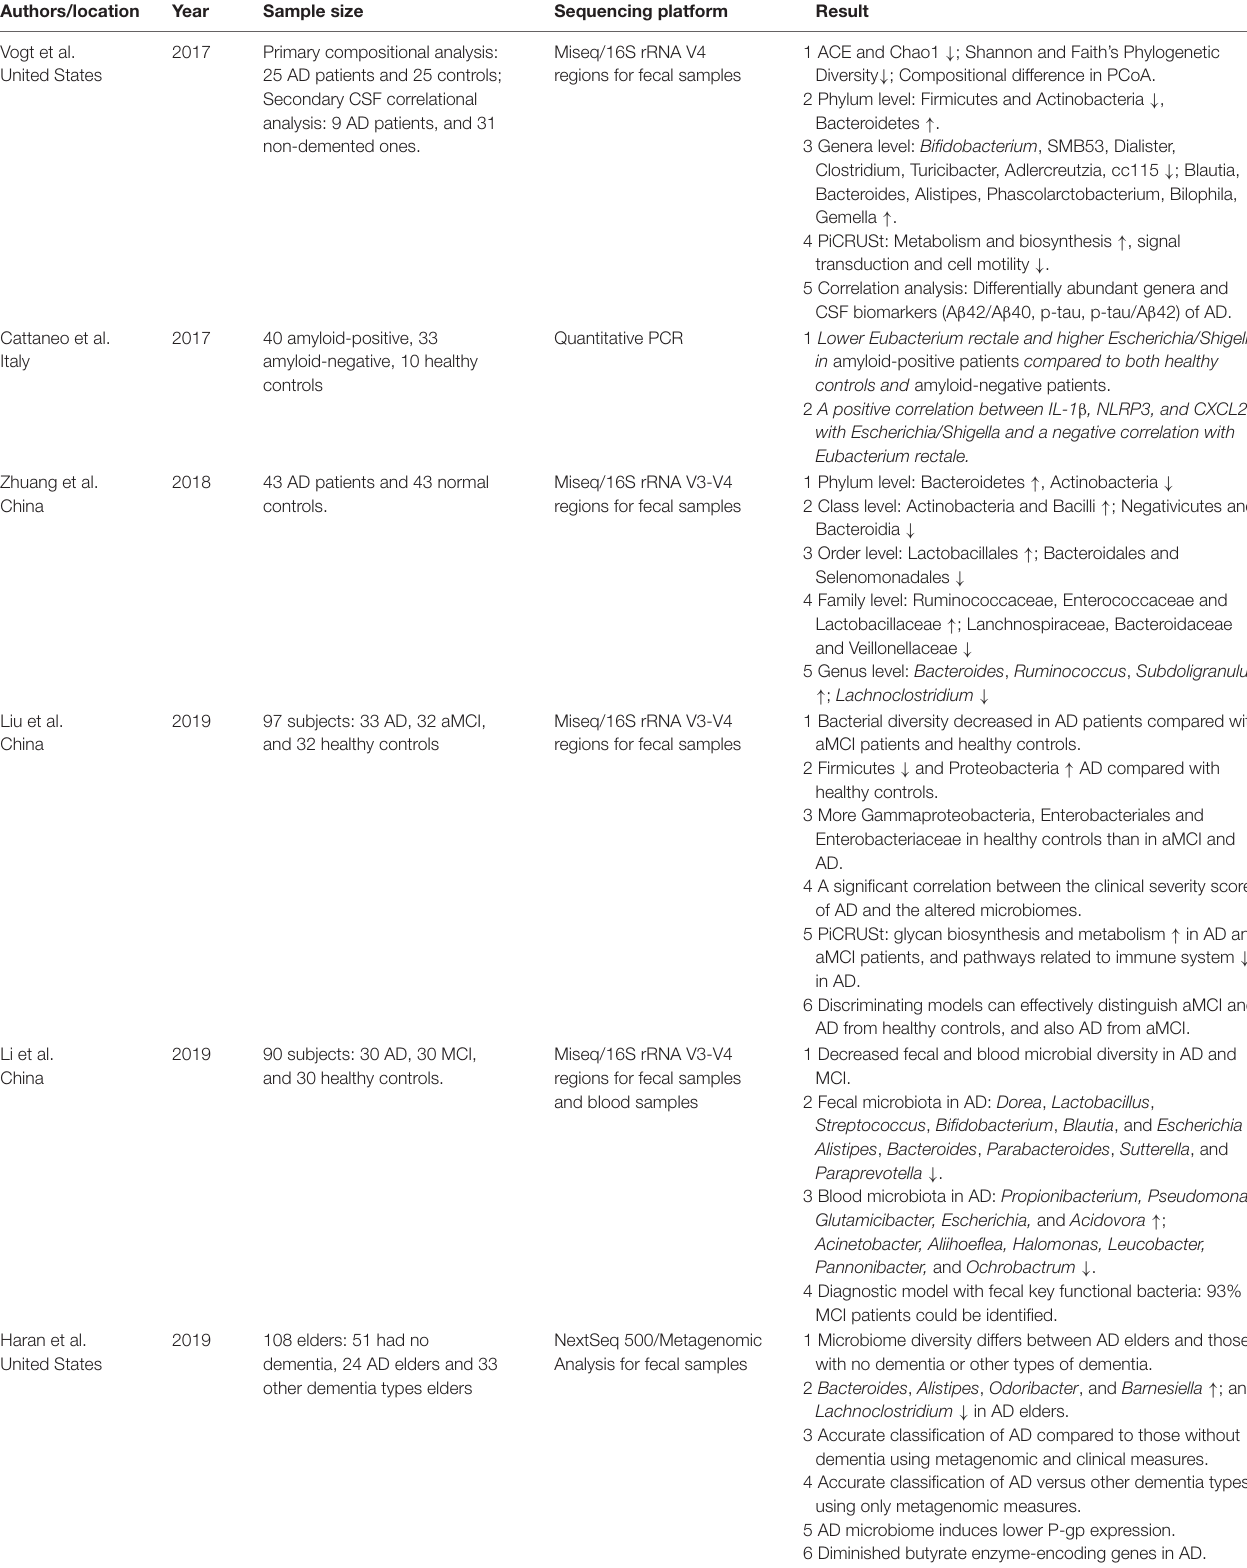
TABLE 1 | Clinical microbiome studies in Alzheimer’s